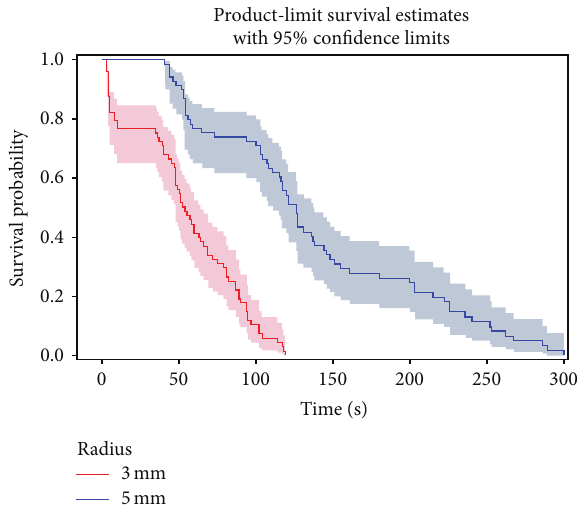
Figure 4: The Kaplan-Meier estimate of the survival function (probability of cyclic resistance) of rotary instruments categorized by the radius of canal curvature.